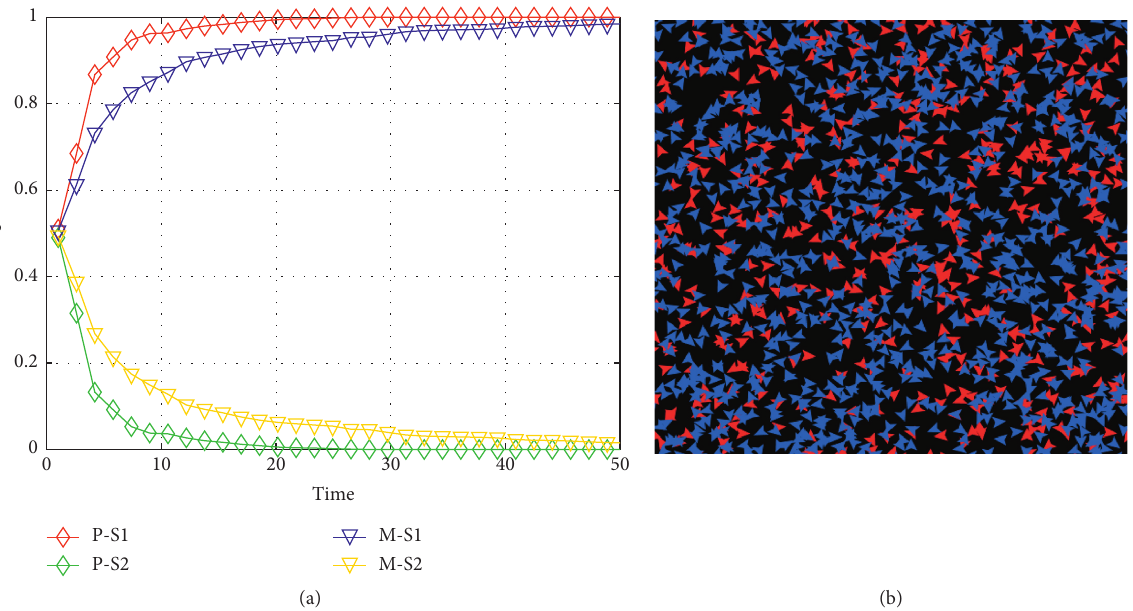
Figure 3: The improved simulation results of Case 4. (a) The process of strategy evolution. (b) Results of the group strategy